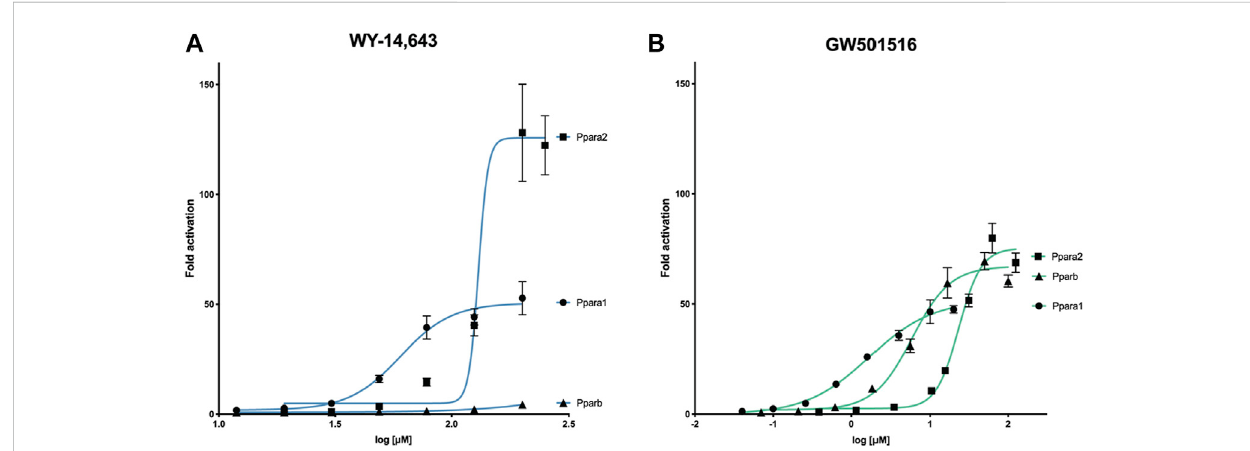
FIGURE 1 Activation of Atlantic cod Ppara1, Ppara2, and Pparb ligand-binding domain by (A) WY-14,643 and (B) GW501516 using luciferase reporter gene assays. COS-7 cells transfected with gmPpara1, gmPpara2, and gmPparb were exposed to either WY-14,643 or GW501516 at increasing concentrations. Concentration-response curves are presented as mean ± SEM fold activation of the receptors in comparison to solvent control (DMSO). Data were recorded from three independent experiments with three technical replicates. Concentration-response curves were calculated by non-linear regression (4 parameters, GraphPad PRISM v.